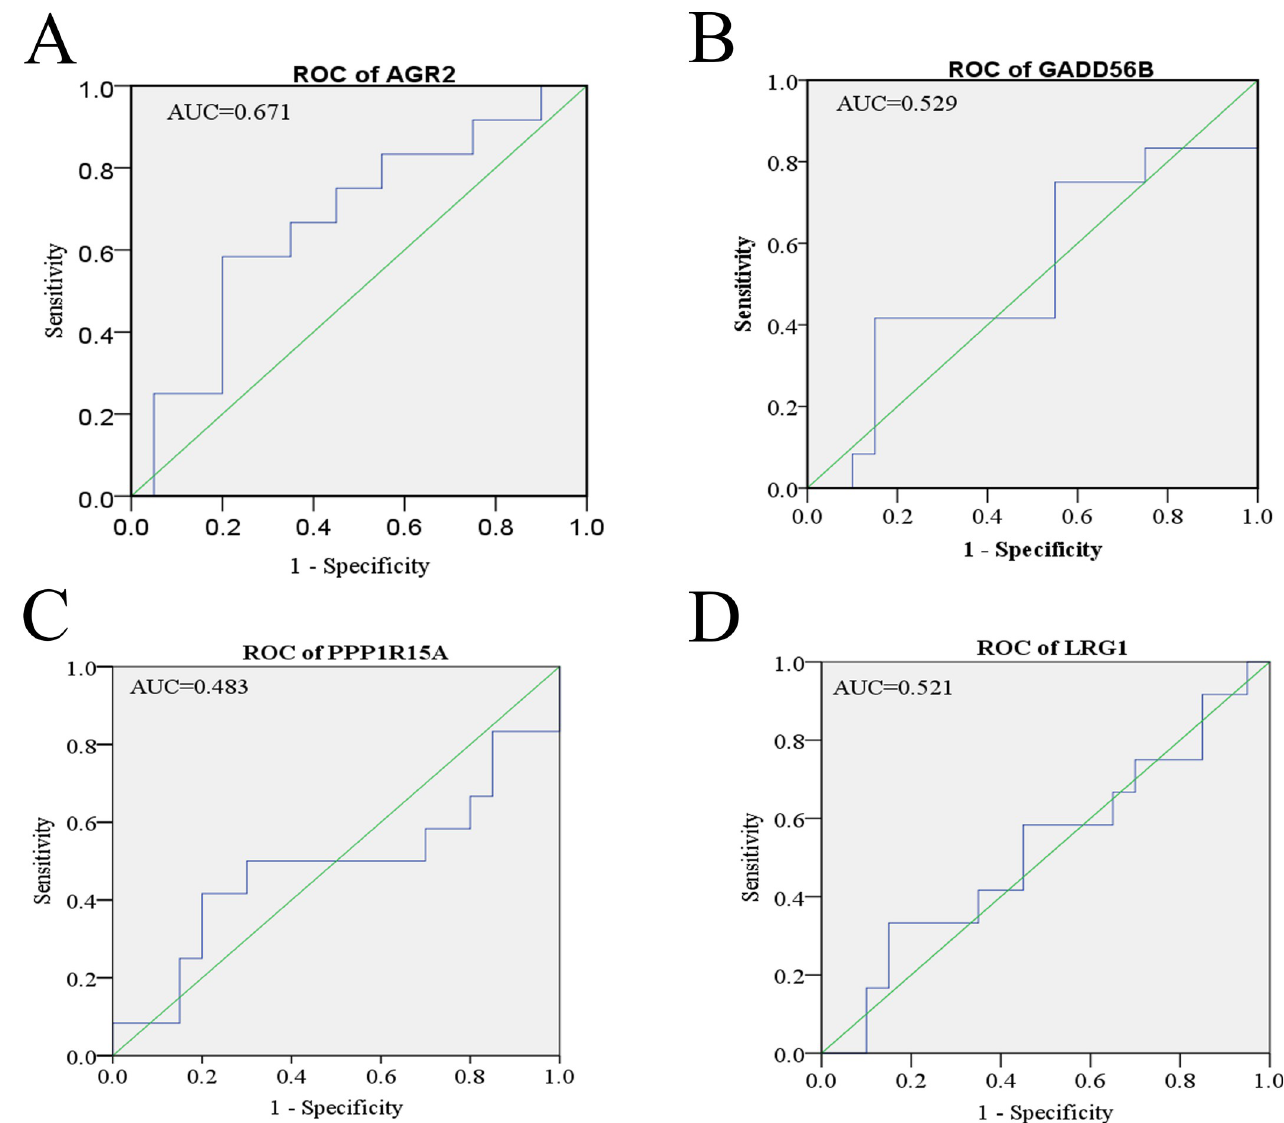
Fig 4. AGR2 in both breast cancer and prostate cancer is likely may be associated with endocrine sta- tus and treatment response. As an ER-localized molecular chaperone, AGR2 regulates the folding, trafficking, and assembly of cysteine-rich transmembrane receptors and the cysteine-rich intesti- nal glycoprotein mucin [45]. In the prostate carcinoma, AGR2 is induced by androgens [46]. In terms of protein function, AGR2 is involved in cell migration, and cellular transforma- tion, and metastasis as well as being a p53 inhibitor [37, 45, 47]. The role of AGR2 has been implicated in inflammatory bowel disease and cancer progression [48]. Pohler et al., [49] reported that AGR2 promotes colony formation in lung cancer cells (H1299), while overex- pressing AGR2 in undamaged cells does not change their cell-cycle parameters. Furthermore, in prostate cancer, extracellular AGR2 combines with vascular endothelial growth factor (VEGF), before activating VEGF receptor signalling and inducing angiogenesis. Intracellular AGR2 induces EMT gene transcription through stabilizing p65, and then facilitates metastatic